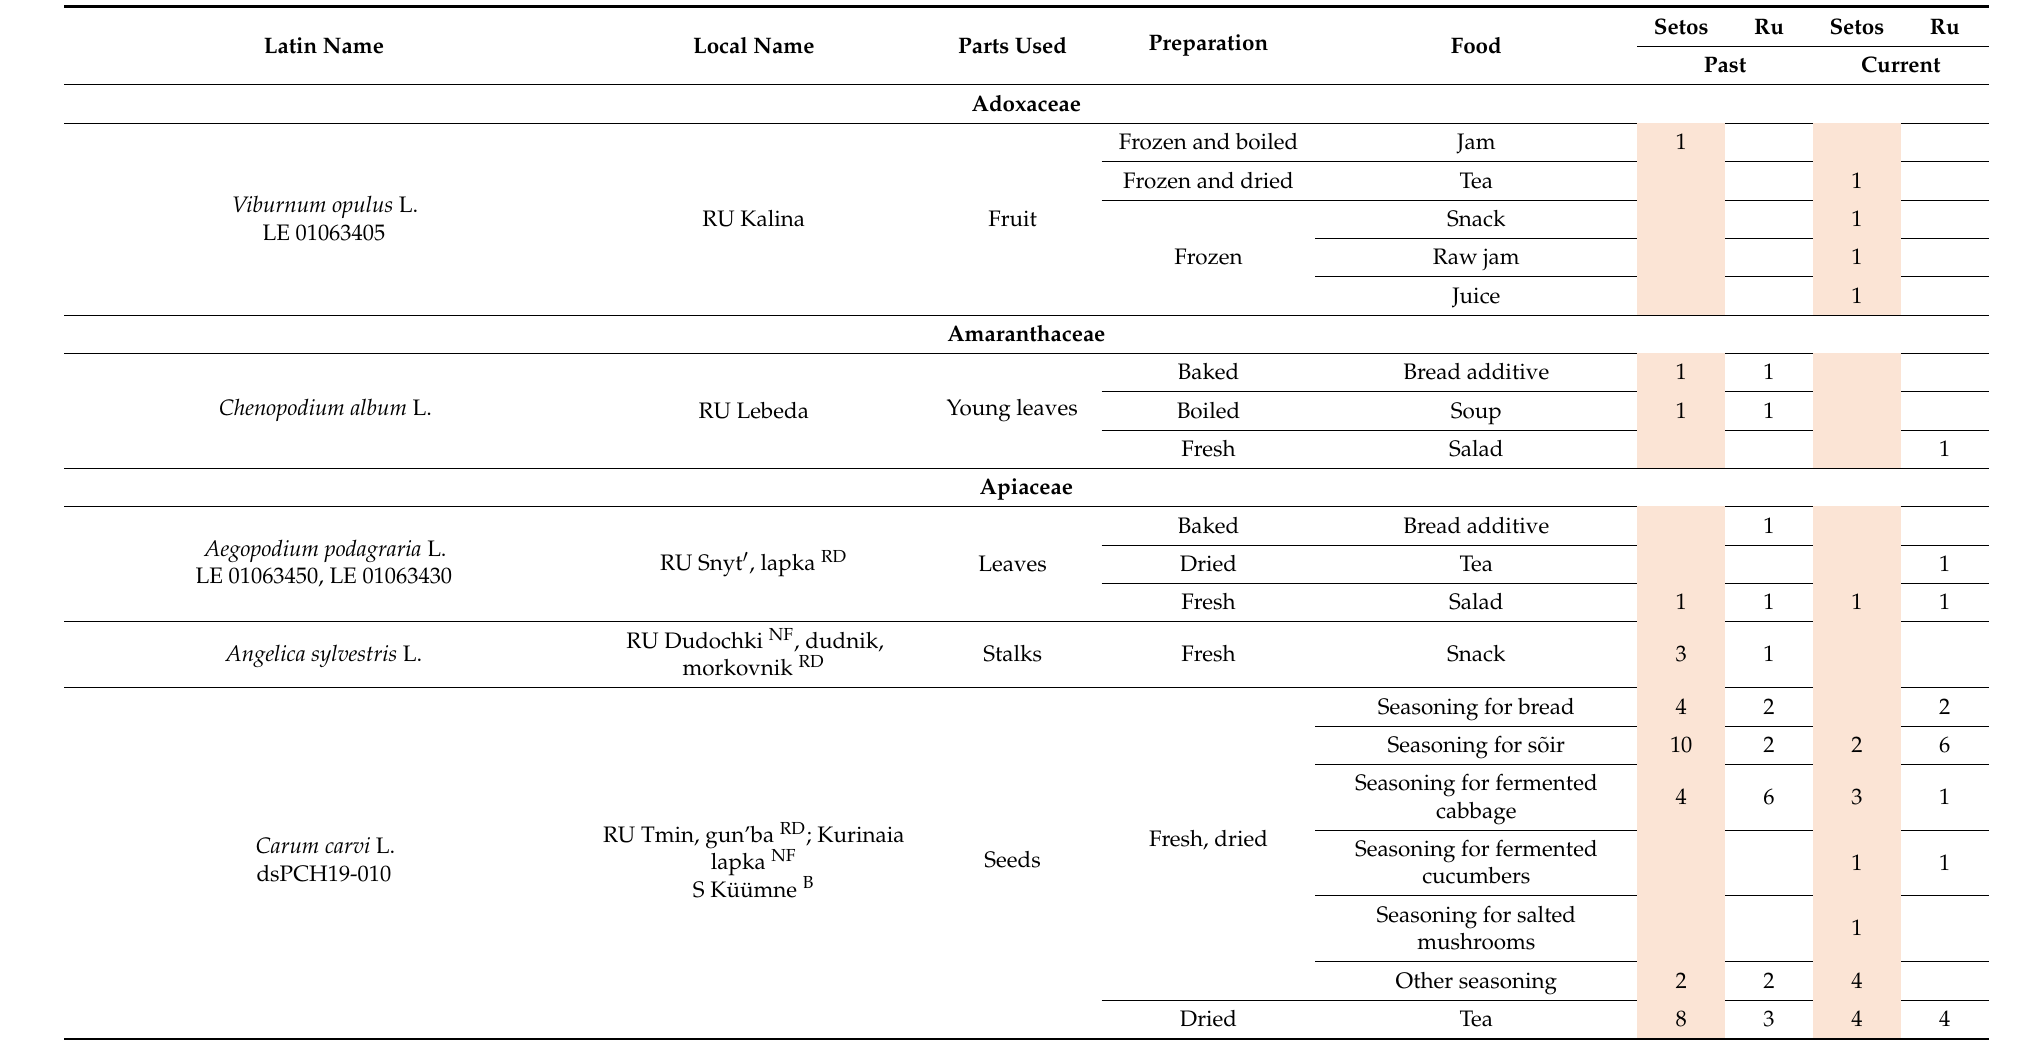
Table 4. Use of wild food plants by Setos and Russians today and in the